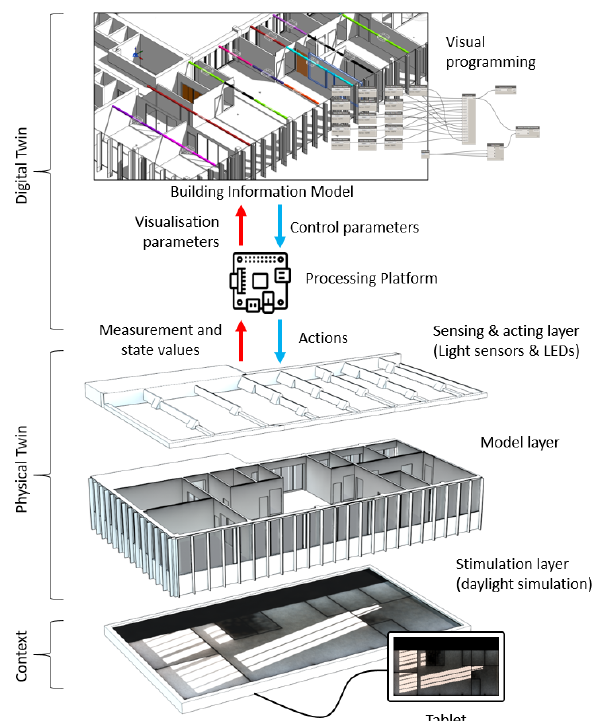
Figure 10. The concept of a prototype created to investigate the interactivity through IoT between a physical model containing sensors and its digital twin